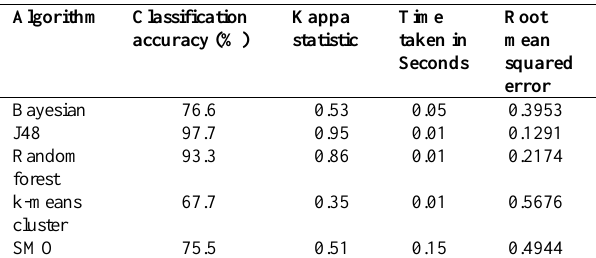
Table 2. Classification accuracy of the different algorithms in total data set.